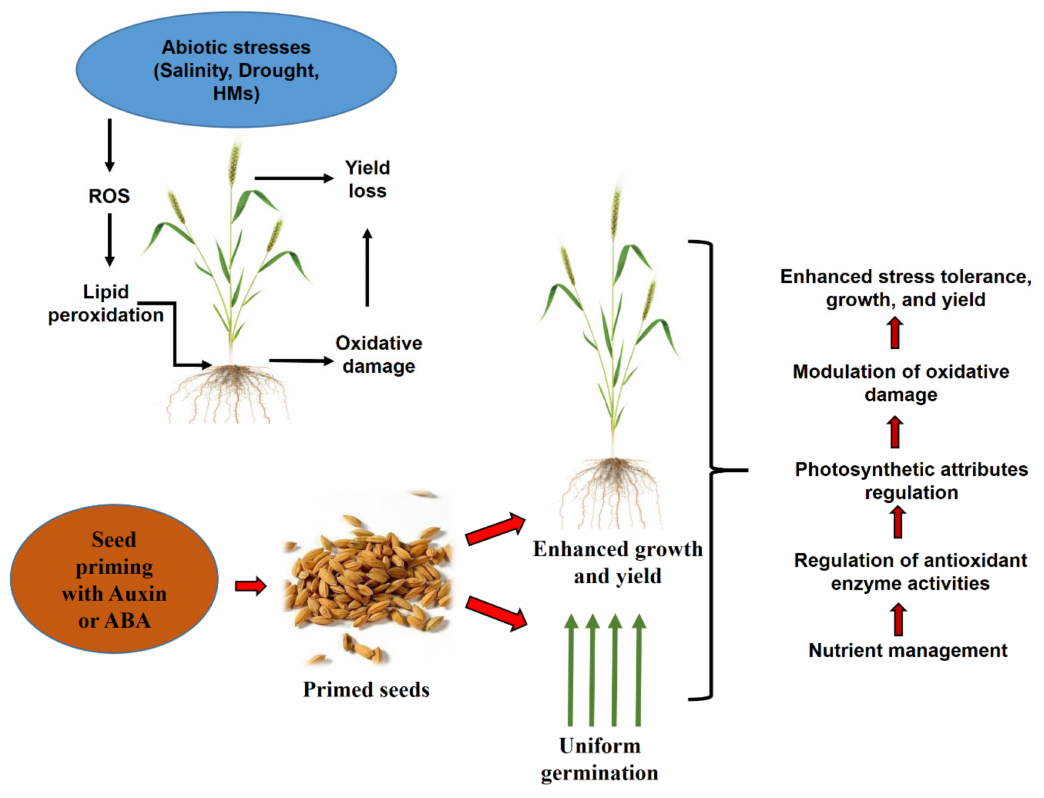
Figure 2. Proposed possible mechanisms used by auxin-and abscisic acid (ABA)-priming and their roles on the germination, growth, and development of plants under different